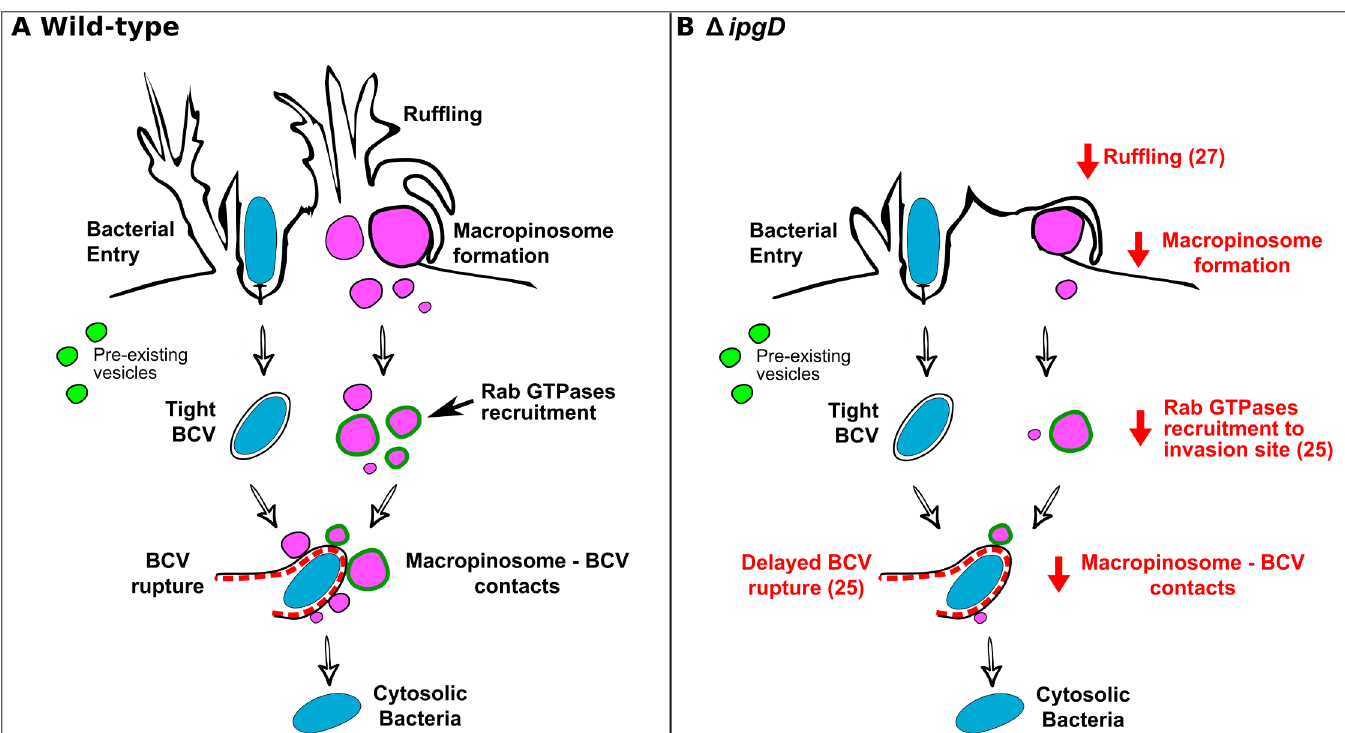
Fig 6. New model of S . flexneri early invasion into epithelial cells. Wild-type (A) is compared with Δ ipgD (B). Altered steps are indicated in red with references to relevant work. S . flexneri (blue) induces membrane ruffling resulting in macropinosome formation (pink) in conjunction with its entry into a tight BCV. Rab GTPases (dark green) are then recruited to macropinosomes. Finally macropinosomes and the BCV come into direct contact at the onset of vacuolar rupture (dashed line) and bacteria escape to the cytosol. Pre-existing endocytic vesicles (light green) are not recruited to the invasion site. Δ ipgD reduces membrane ruffling, resulting in fewer macropinosomes that can then be targeted by Rab GTPases (observed as on overall reduction of Rab recruitment to the invasion site). As a result less macropinosome- BCV contacts are formed and vacuolar ruptured is delayed.